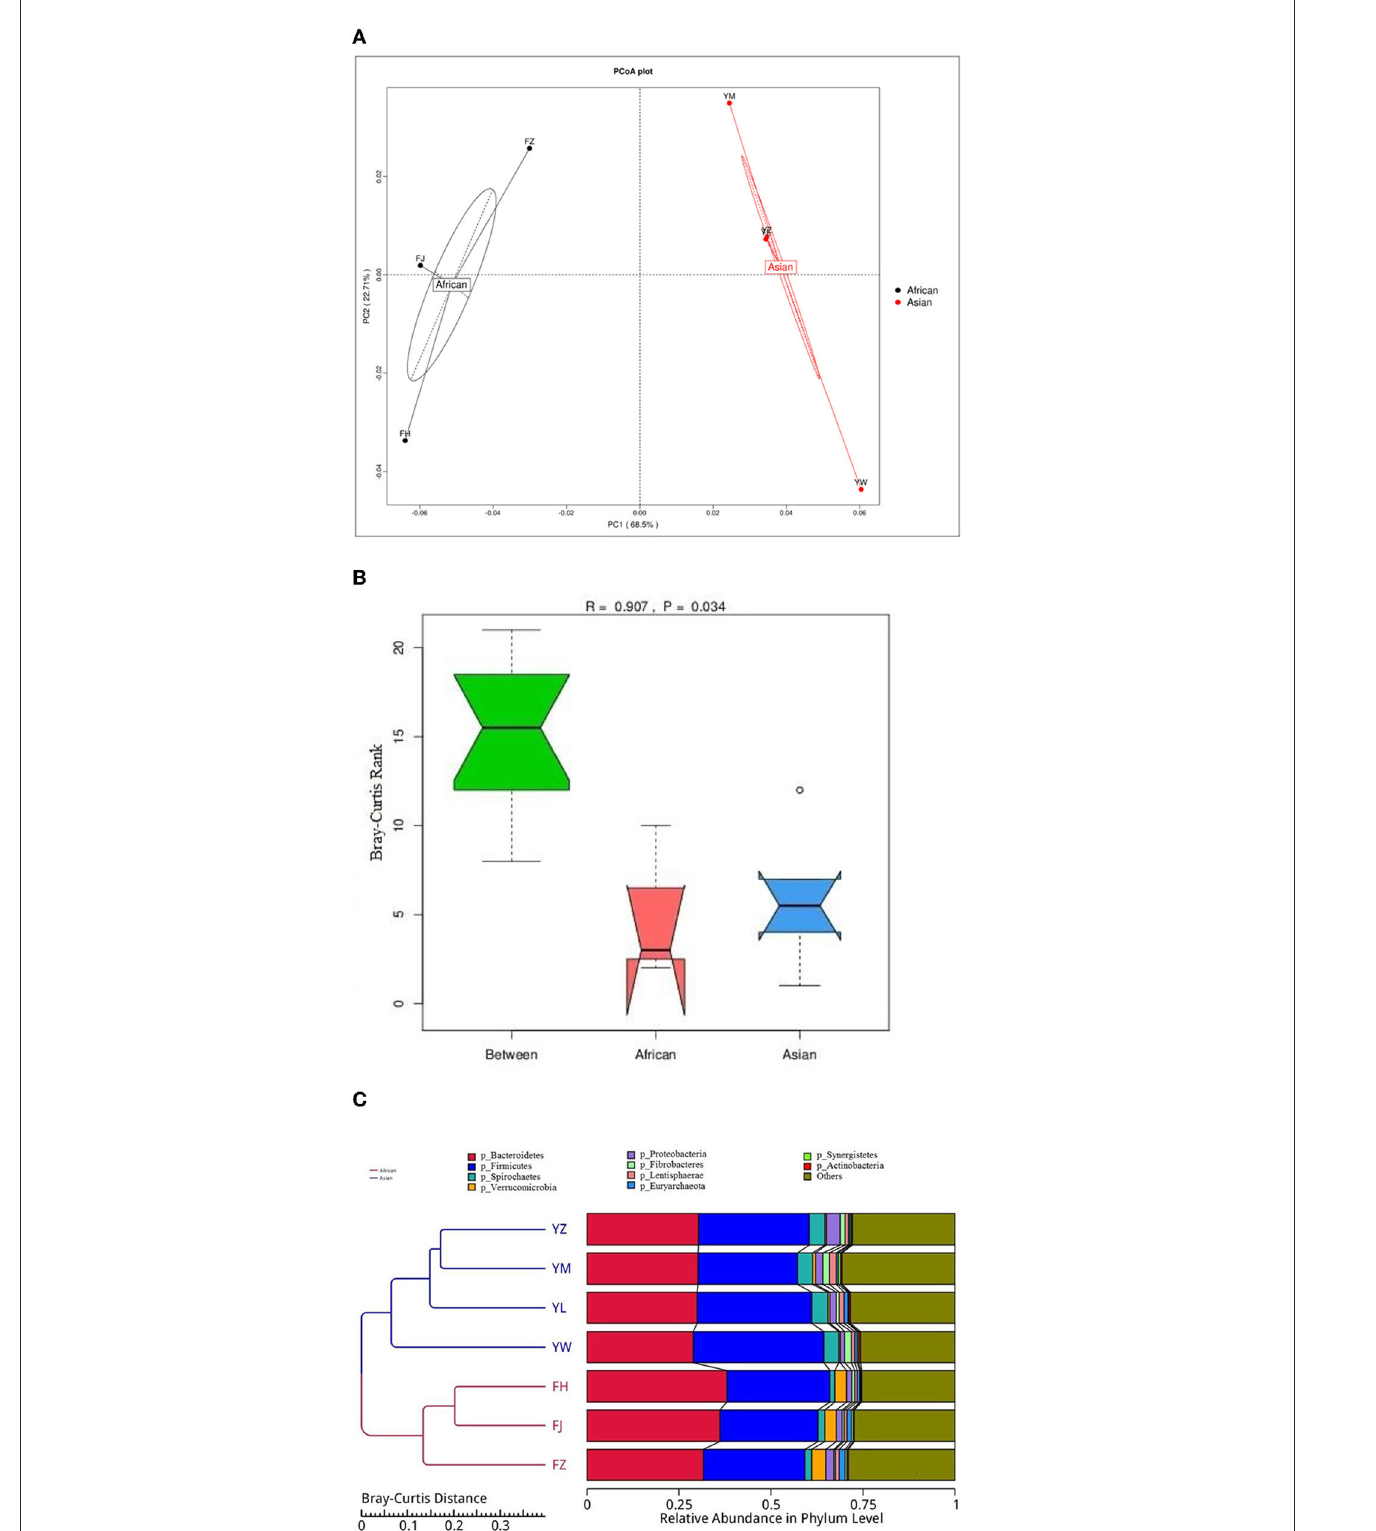
FIGURE3 (A) Principal Co-ordinates Analysis ( PCoA) of microbiota from African and Asian elephants at the phylum level (Bray-Curtis distance); (B) ANOSIM analysis of microbial composition at the phylum level. The y-axis of the plot represents the ranked Bray-Curtis distance. Between is the combined microbial information at the phylum level from both groups. A higher median line of between than the median line of the other two groups means that the variance between groups was higher than variance within groups; (C) Cluster tree based on Bray-Curtis distance at the phylum level. The left side is the Bray-Curtis distance clustering tree structure; the right side is the relative abundance distribution map of each sample at the phylum